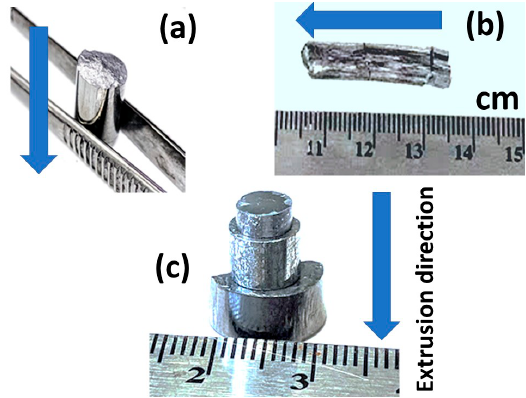
Figure 4 . ( a ) ZnSb and ( b ) Zn 13 Sb 10 extruded using extrusion die with extrusion ratio (ER) = 3.08, ( c ) three ZnSb samples extruded with three dies of different ERs. Arrows show the extrusion direction in each panel.